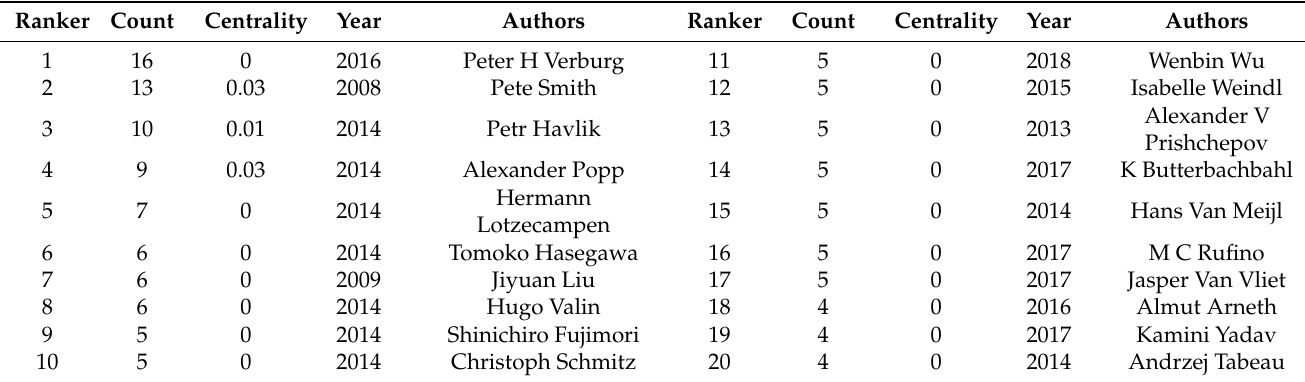
Table 1. Author information table of the top 20 published